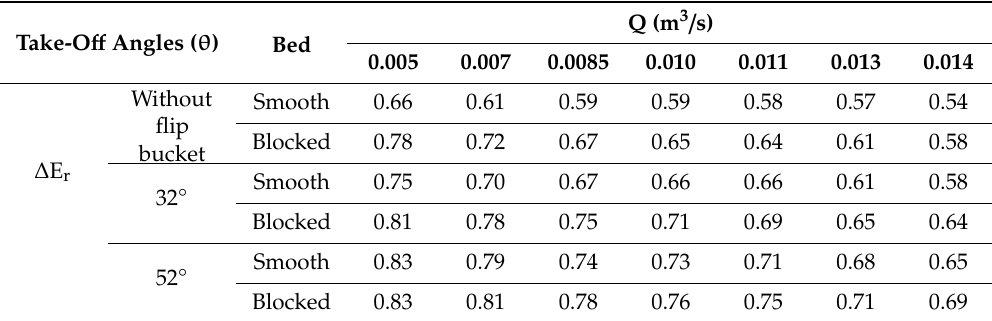
Table 5. Relative energy-dissipation values for smooth and blocked bed (FLOW-3D results). Take-Off Angles (θ)